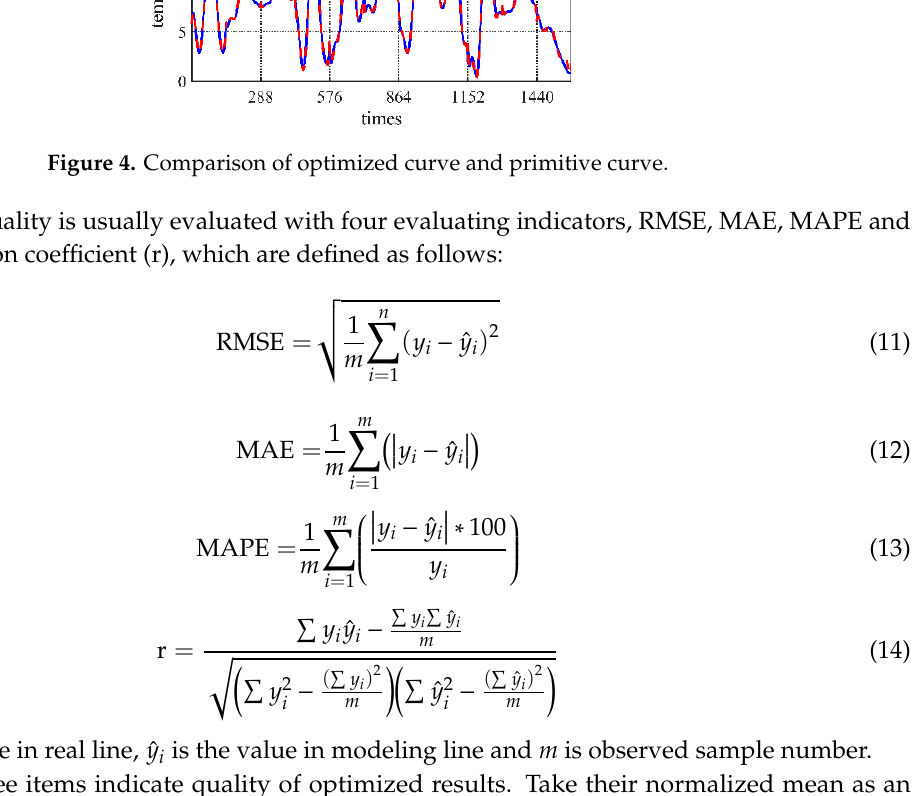
Figure 6. The Pearson correlation coefficient of several days. 4.2. Influenced Factors Analysis